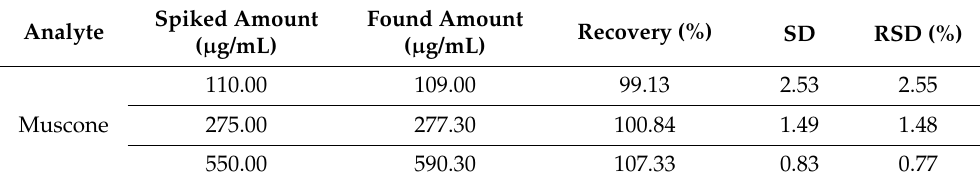
Table 8. Recovery (%) of muscone by the GC–MS/MS method (n = 5).